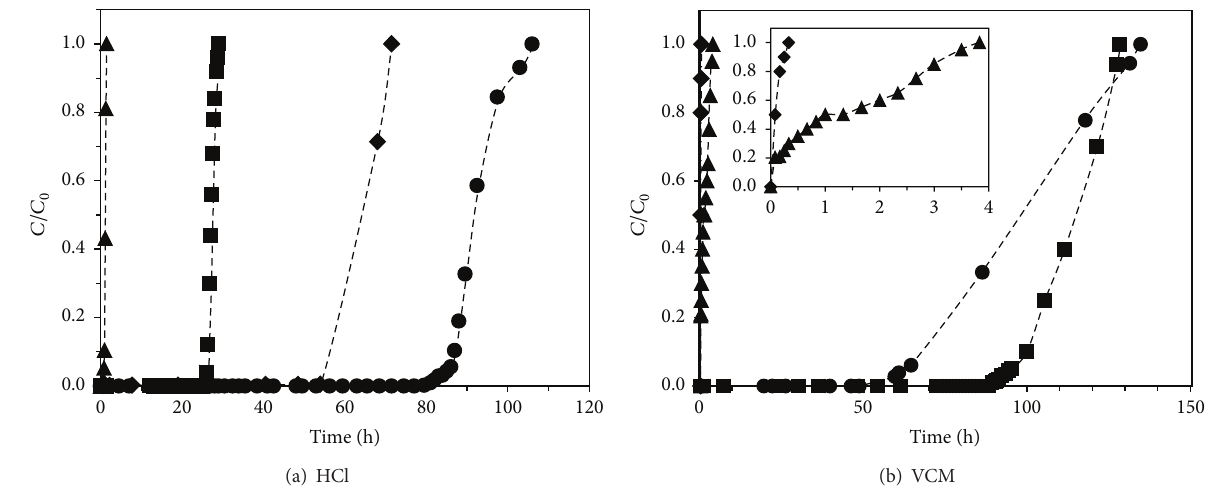
Figure 5: Breakthrough curves of HCl (int. 600 ppm) and VCM (int. 20 ppm) contaminated in H 2 ; ◼ GAC, e 6 N NaOH/GAC, 󳵳 SiO 2 , and 󳶃 Al 2 O 3 balls.